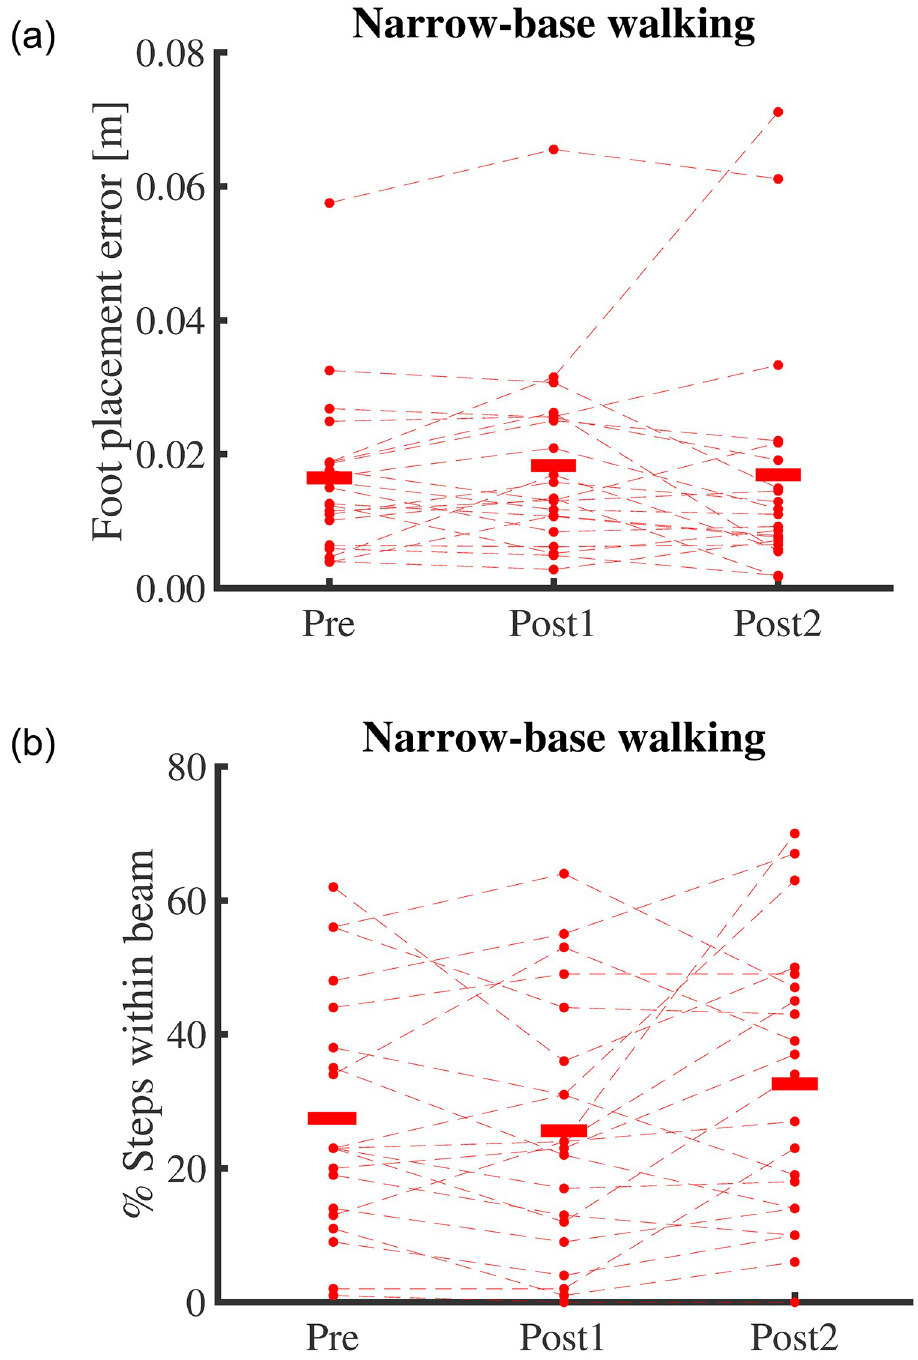
Fig 3. (a) Foot placement error and (b) percentage of the steps within the beam in narrow-base walking at time-points Pre, Post1, and Post2. Thin lines represent individual subject data. Red horizontal lines indicate means over subjects.